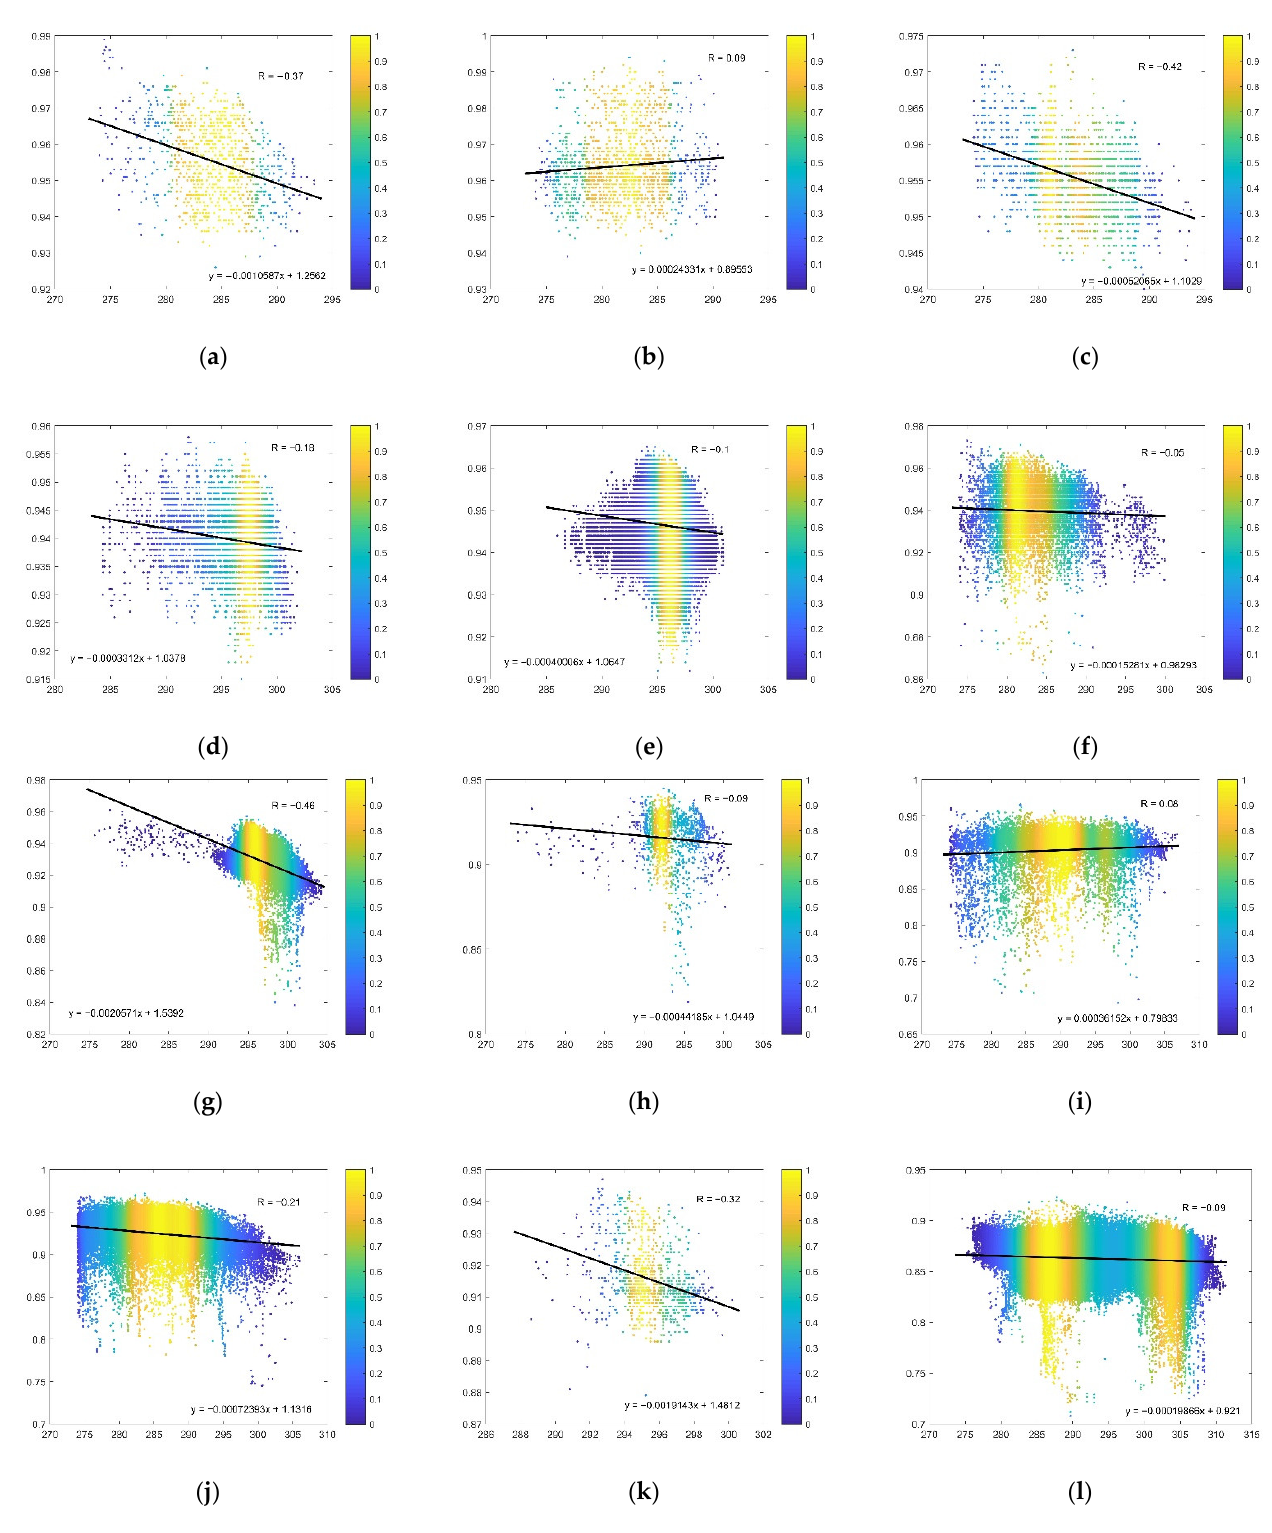
Figure 5. The density scatter diagrams between 10H emissivity (vertical axis) and SKT (horizontal axis) for the 12 vegetation types. ( a ) deciduous needleleaf forests; ( b ) evergreen needleleaf forests; ( c ) mixed forests; ( d ) deciduous broadleaf forests; ( e ) evergreen broadleaf forests; ( f ) woody savannas; ( g ) savannas; ( h ) cropland/natural vegetation mosaics; ( i ) croplands; ( j ) grasslands; ( k ) closed shrublands; ( l ) open shrublands.